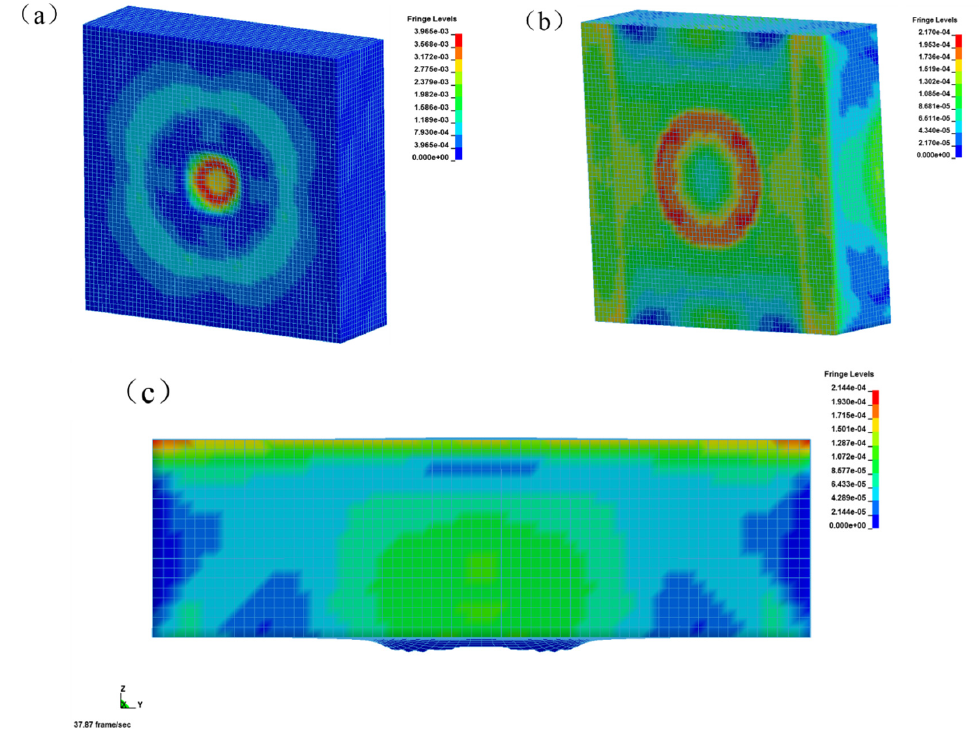
Figure 17. Stress nephograms of coated reinforced concrete slab at time t = 1000 µ s: ( a ) face surface blast; ( b ) back blast surface; ( c ) side